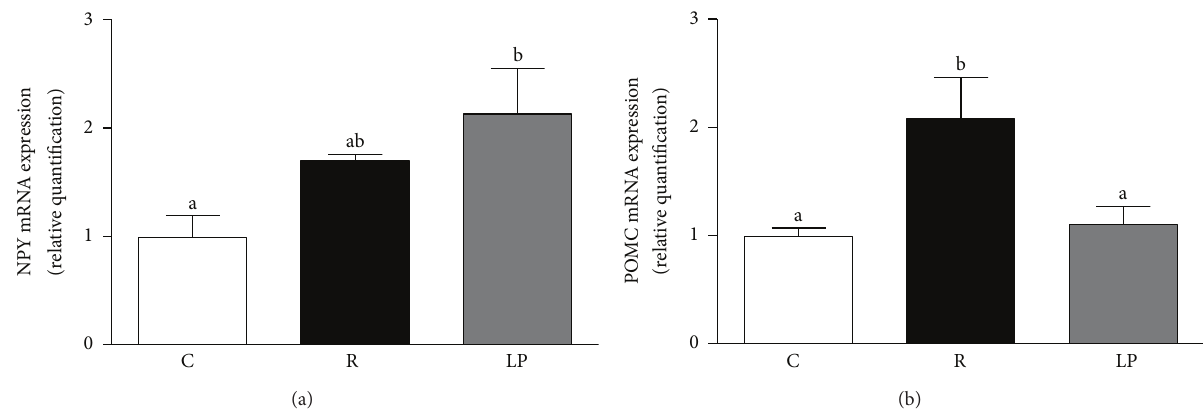
Figure 4: NPY (a) and POMC (b) mRNA expression in hypothalamus of control (C), recovered (R), and low protein (LP) rats. Data are presented as means ± SEM. Mean values with unlike superscript letters were significantly different ( 𝑃 < 0.05 , LSD test).